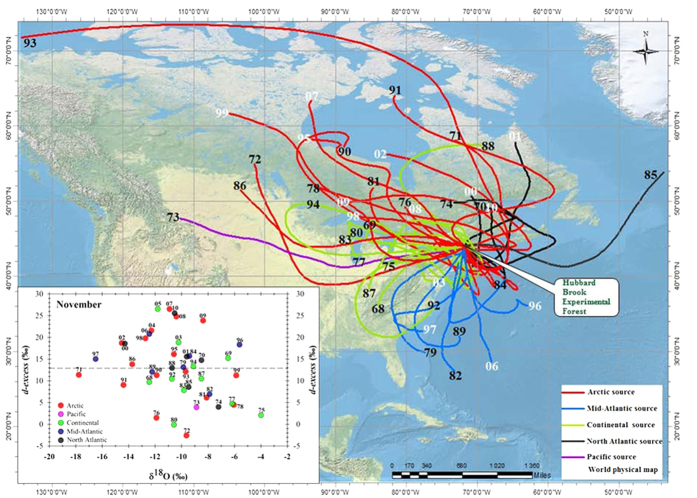
Air parcel back trajectories (main) and δ18O- d-excess values (inset) plot for November, 1968–2010.Five different colors indicate the 5 sources during the years associated with a negative AMO (black year numbers) and a positive AMO (white year numbers) phase. 40%, 26%, 16%, 16% 2% of trajectories show Arctic (red), Continental (green), North Atlantic (black), Mid-Atlantic (dark blue) and Pacific (purple) show, respectively. 57% of trajectories show northern sources: including Arctic and North Atlantic after the start of 1979 sea ice decline and 69% of trajectories show northern sources during positive AMO (start 1995) with higher d-excess values (>15‰). Figure created using ArcGIS 10.2.2.3552 (http://www.esri.com/software/arcgis/) with HYSPLIT model results40
http://journals.ametsoc.org/doi/abs/10.1175/BAMS-D-14-00110.1.